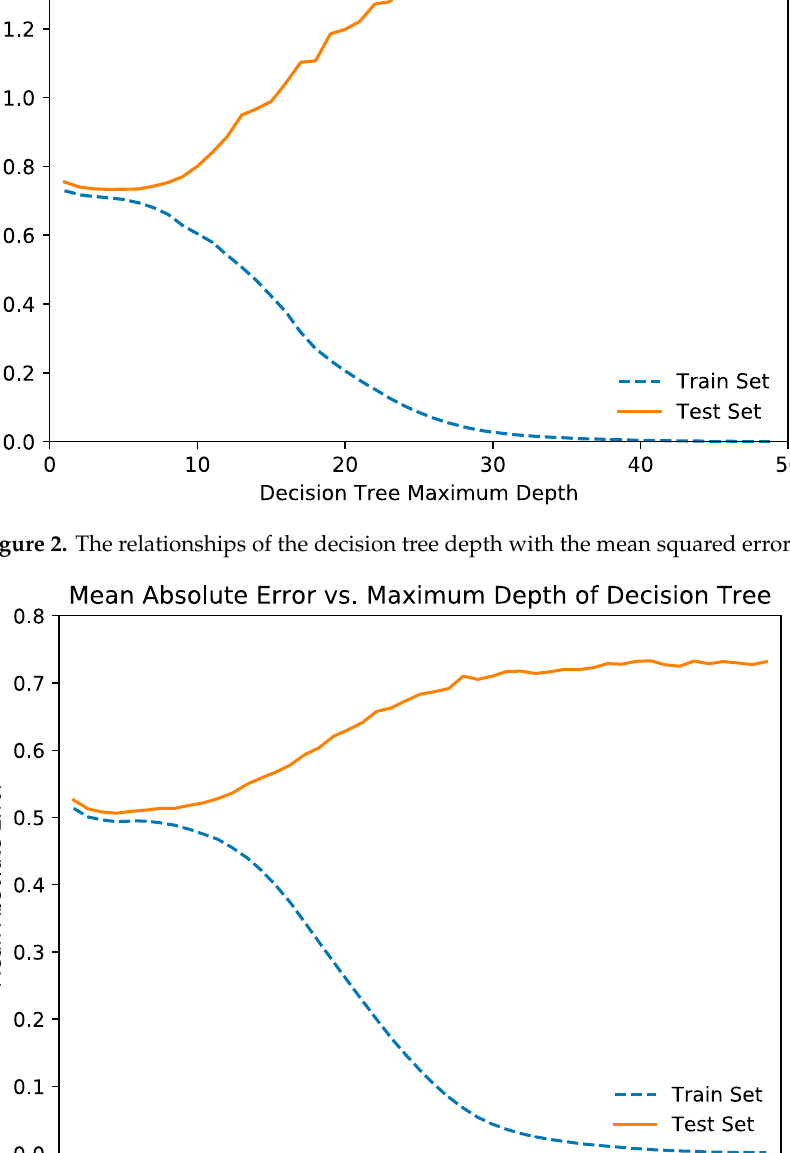
Table 4. Metrics for the artificial neural network (ANN) regression model for cost.